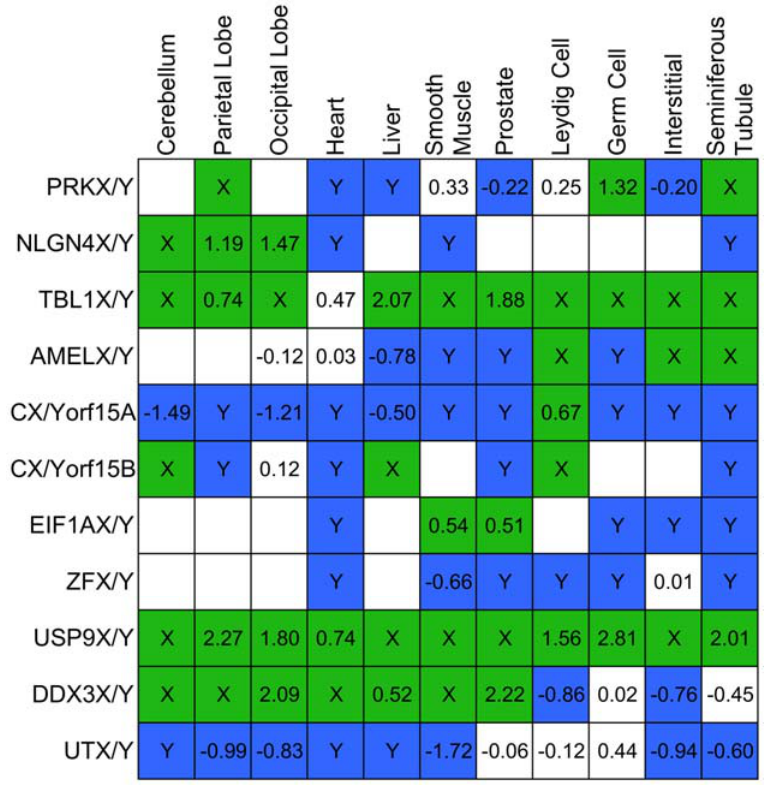
Figure 5. Tissue-specific divergence between human X and Y gametologs. We compared divergence in gene expression based on the presence or absence of gametolog expression and, when both gametologs in a pair were expressed, used the fold change to compare the expression levels between the two gametologs in each pair (see Materials and Methods). Blue field indicates tissues in which the Y gametolog is expressed at a higher level than the X gametolog; green field indicates tissues in which the X gametolog is expressed at a higher level than the Y gametolog; white field with a value indicates similar (less than 25% different) expression for X and Y; and an empty white field indicates that neither gametolog is expressed in a particular tissue. Numbers represent log 2 ( X / Y ), where X and Y are X and Y expression values, respectively. Labels ‘‘X’’ or ’’Y’’ indicate that only the X or only the Y gametolog is expressed. The data for all 11 gametologous pairs present on the array from a study by Su and colleagues [33] are shown (TMSB4X/Y pair was not present on the array).